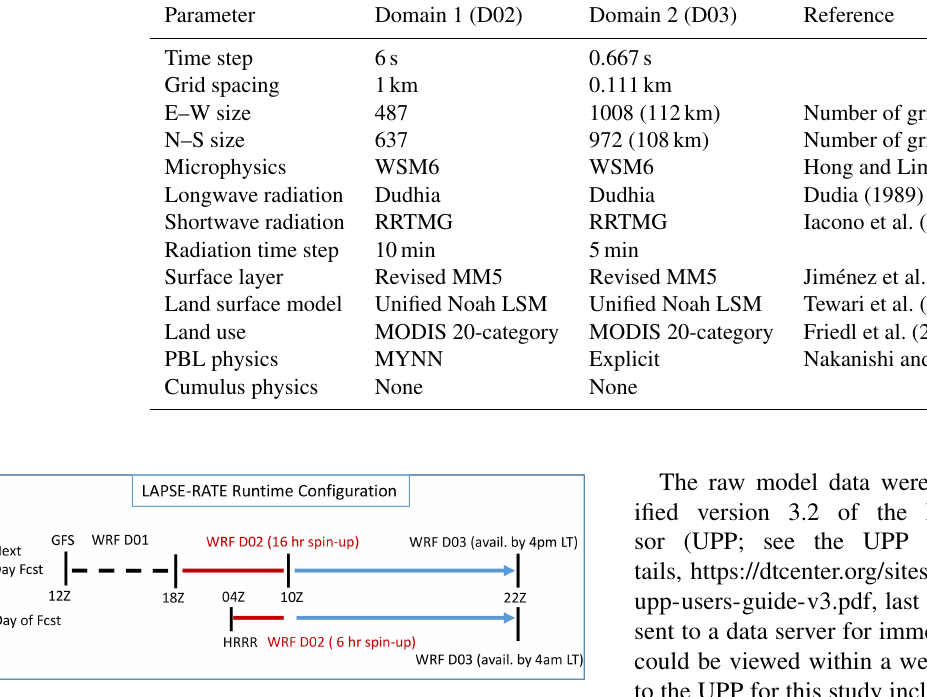
Figure 2. Input, timing and availability for WRF LES simulations which were executed twice per day. Next-day planning guidance was generated using forcing from the 12:00UTC GFS run while day-of guidance was driven using data from the 04:00UTC HRRR run. Note that the GFS runs required three concentric nests to down- scale from 0.25 ◦ to 111m grid spacing using WRF LES. The dashed black line represents the spin-up period for D01 before D02 is initi- ated starting at 18:00UTC. The red solid lines indicate the spin-up period for D02 (1km grid spacing) in both simulations while the solid blue lines indicate the 12h period over which WRF LES (D03) was valid. Data from the next-day GFS-forced run were available at 16:00MDT while data from the day-of HRRR-forced run were available at 04:00MDT to support UAS flight